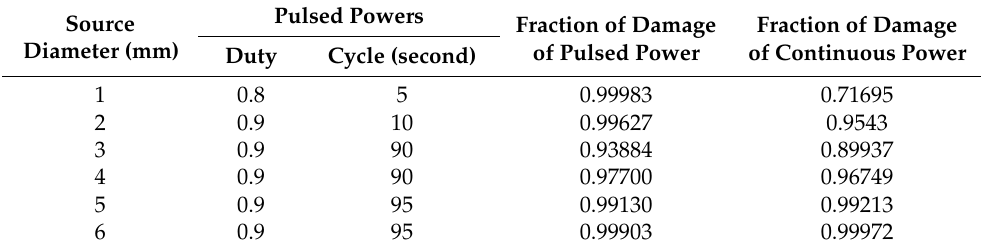
Table 2. Summary of the maximum fraction of tissue damage among the pulsed powers and fraction of tissue damage of the continuous power at the source domain.